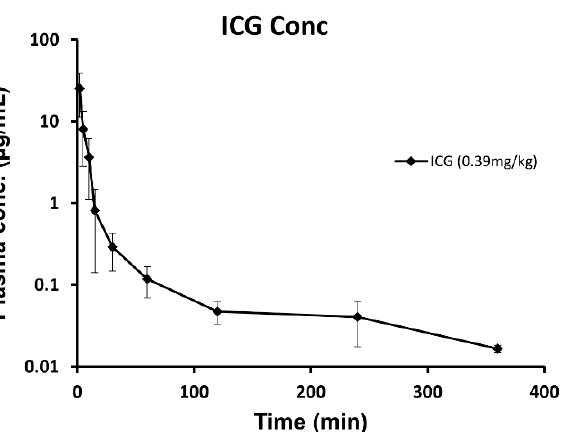
Figure 4. Plasma concentration time profile of ICG after an intravenous (IV) dose of 0.39 mg/kg ICG (mean ± SD, n = 3).